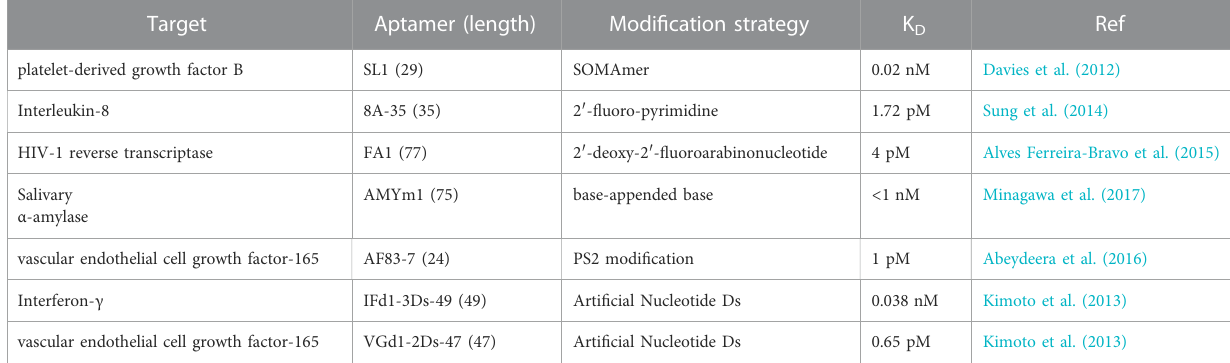
TABLE 1 Chemically modi fi ed aptamers for improving binding af fi